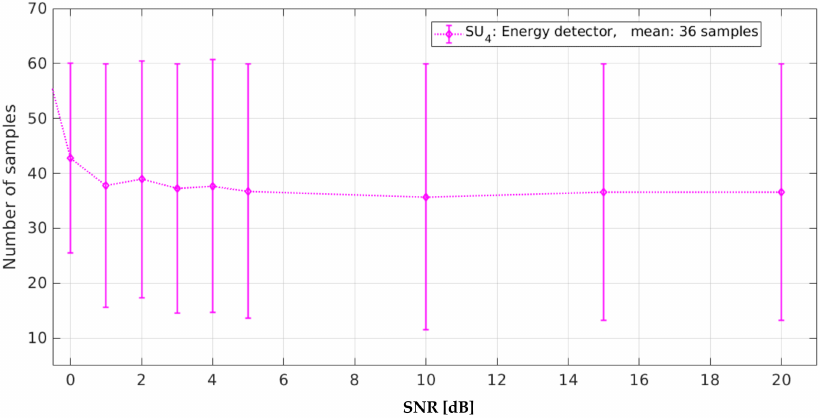
Figure 23. Samples in error for the energy detector.